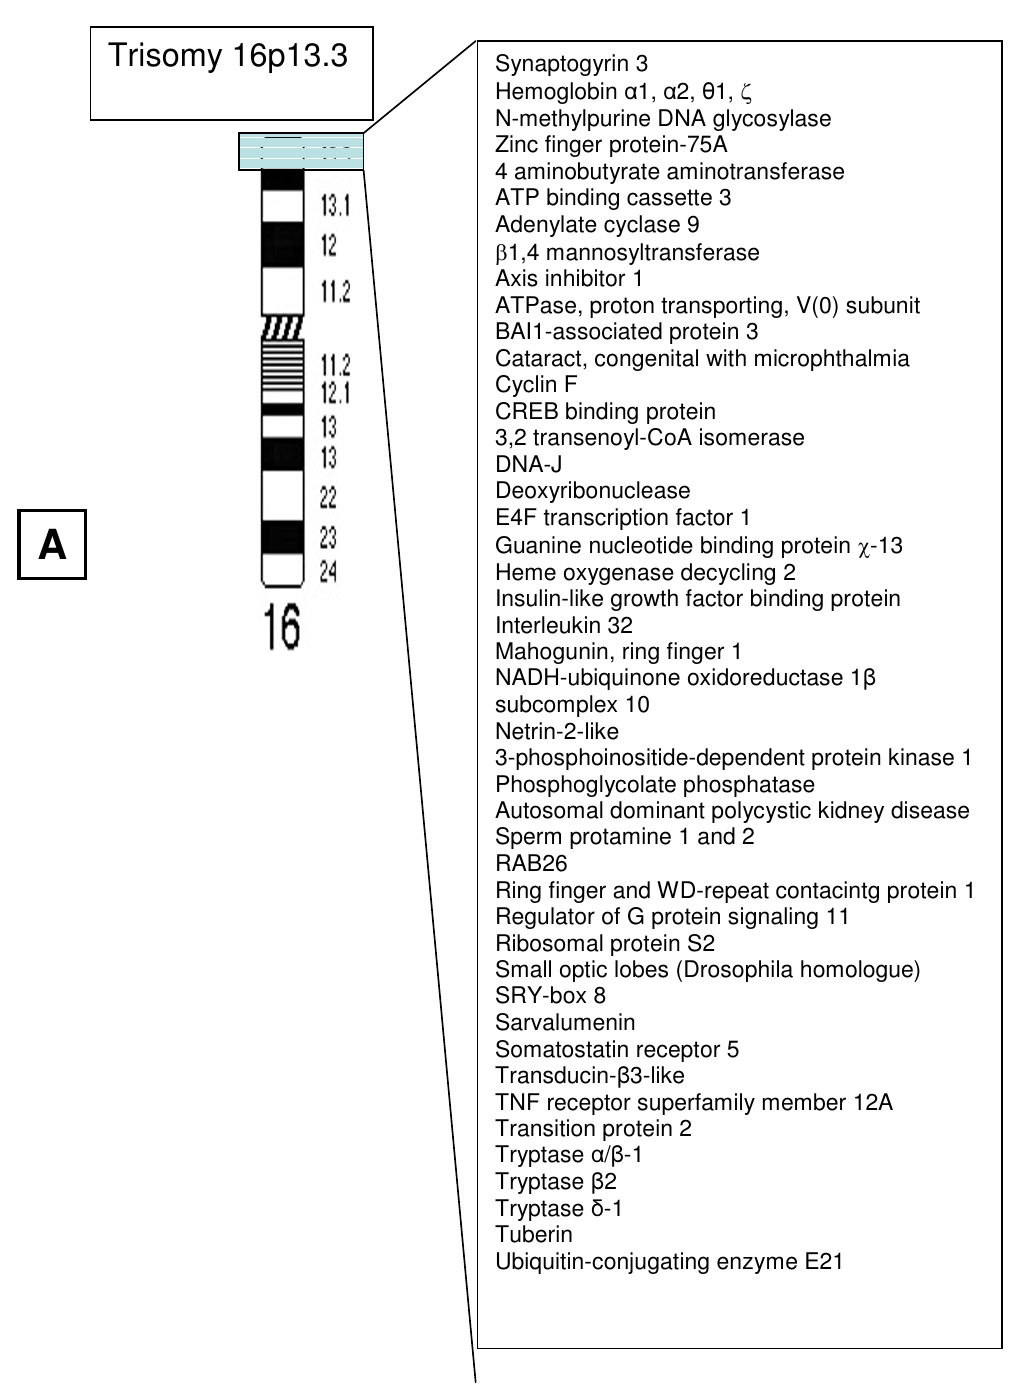
Figure 3 Ideogram of chromosomes 16 with the trisomic region highlighted. Examples of genes known to map to these chromosomal segments are noted, according to the information in build 35.1 of the Homo sapiens sequence on the NCBI Map Viewer and Online Mendelian Inheritance in Man. Hypothetical proteins and open reading frames are omitted from the list. In some cases, the exact order of transcripts is